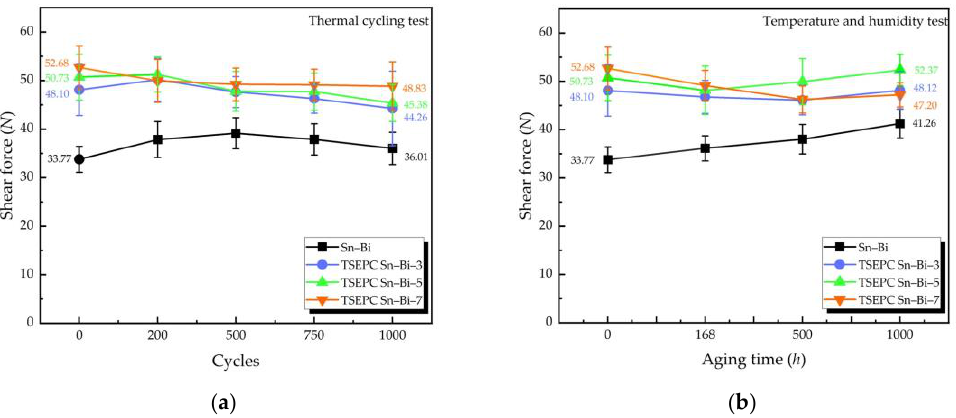
Figure 7. Shear force of Sn – Bi and TSEP Sn – Bi-x (x = 3, 5, 7): ( a ) Thermal cycling test; ( b ) Temperature and humidity test.